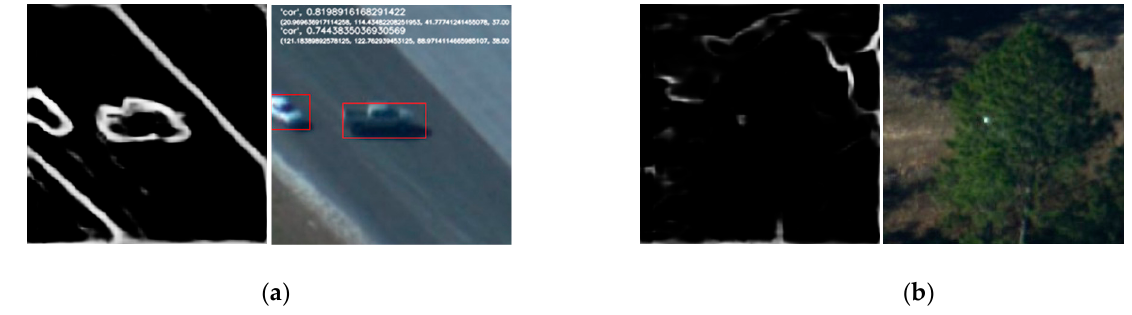
Figure 8. Outputs from template-update network under ( a ) deformation and ( b ) occlusion: left of each